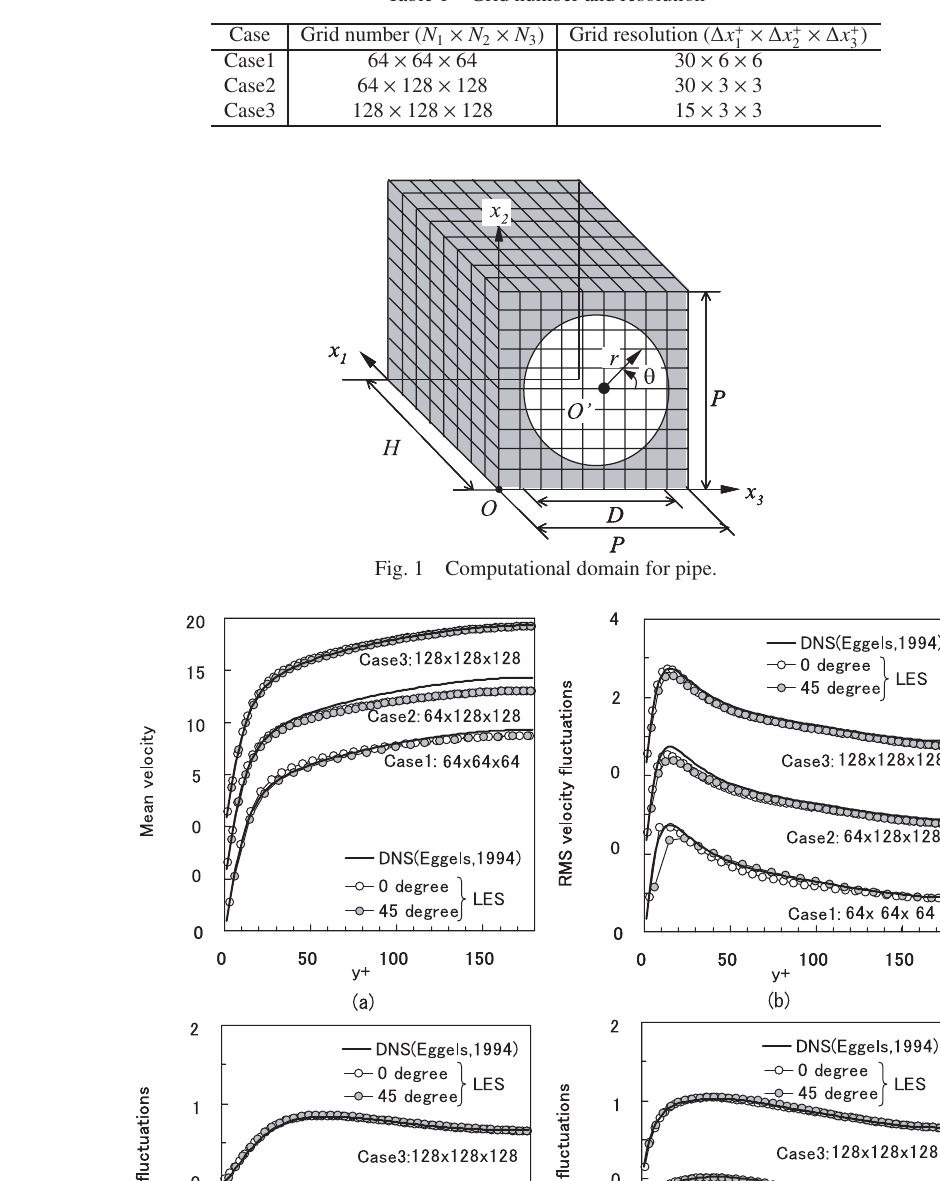
Fig. 2 Mean velocity and velocity fluctuations in pipe flow at Re T = 360: (a) u + u (cid:3) + , (c) u (cid:3) + , (d) u (cid:3) + r , RMS t , RMS 1 , RMS wall is simulated on the Cartesian grid. The computational domain is shown in Fig. 1. Setting D / P = 0 . 9375 and H / D = 5, computations for Case1 to 3 shown in Table 1 are carried out. The Reynolds number Re T = u T D /ν is 360. Grid resolution for this condition is shown in Table 1. After the flow is developed, the flow fields are averaged during 4 t ∗ . The mean streamwise velocity and velocity fluctuations obtained are shown in Fig.2. The results in the directions of